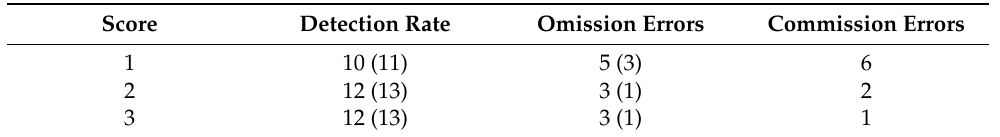
Table 3. Detection rate, errors of omission and commission errors for rock walls (>250 m 2 ) with different score values compared to ground reference data (rock walls and stream gorges). The numbers in the parenthesis are presented with corrected field reference data.